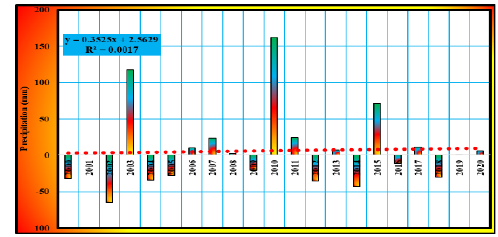
Figure 5: Represents Monsson Rainfall Trend Line in Ghotki district 2000-2020